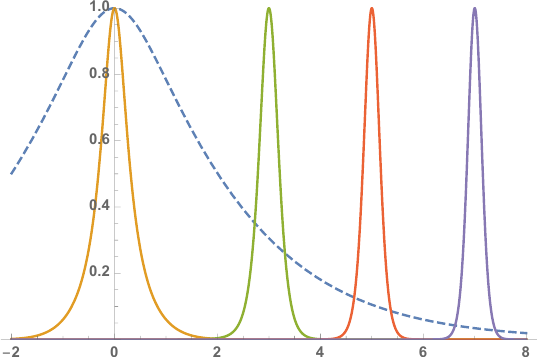
Figure 7. Normalized intensity (dashed curve), and DOC µ ( 0, x ) , µ ( 3, x ) , µ ( 5, x ) , µ ( 7, x ) vs. x , from Equations (8) and (26) with K = 1 and T =